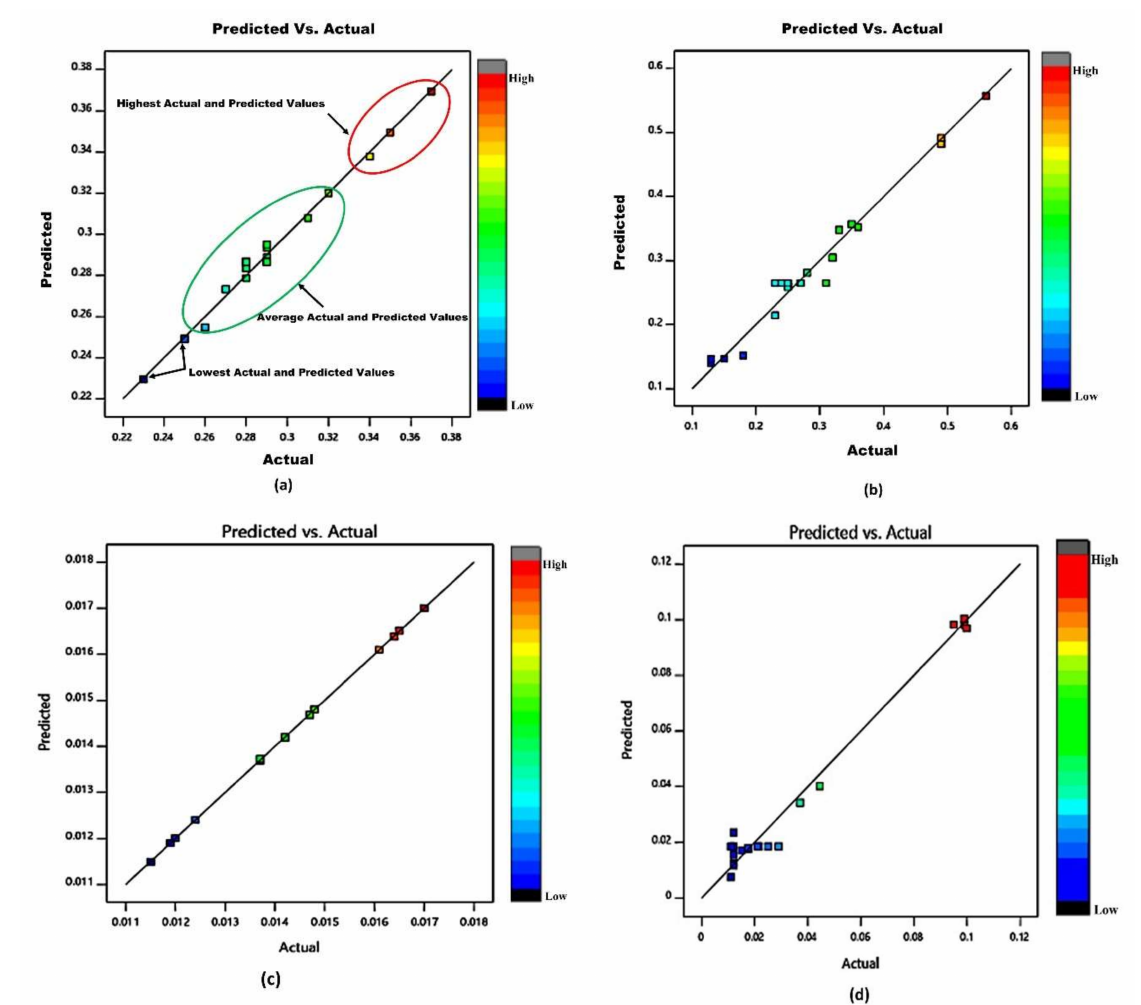
Figure 5. ( a ) Relationship between actual and predicted values of GFRPA66 30 wt.% COF; ( b ) relationship between actual and predicted values of GFRPA66 35 wt.% COF; ( c ) relationship between actual and predicted values of GFRPA66 30 wt.% SWR; ( d ) relationship between actual and predicted values of GFRPA66 35 wt.%